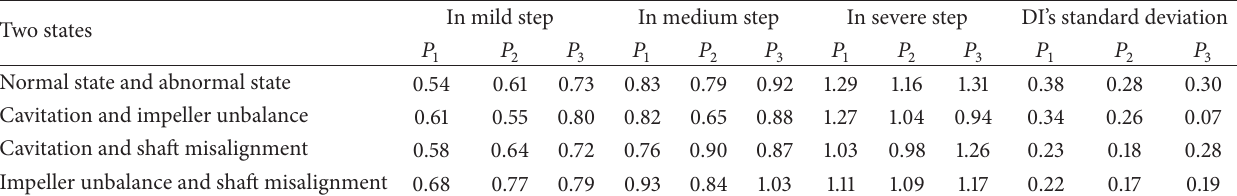
Table 1: DI values and standard deviation of DI values of 3 NSPs between two states from the signals estimated by statistic filter. Two states